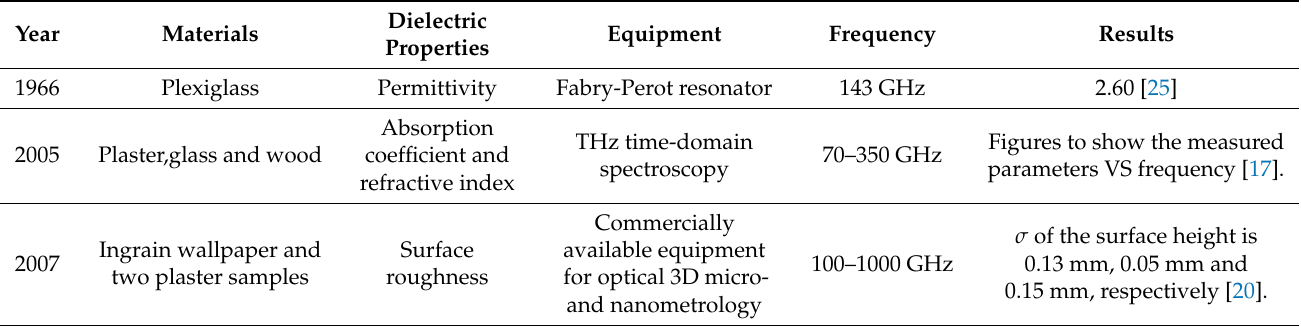
Table 2. Reference Review of Measuring Dielectric Properties of